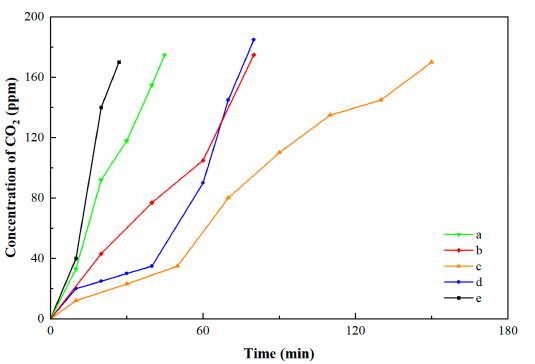
Figure 3. Breakthrough curves of blank carriers were compared at 20 ◦ C: (a) 4A, (b) 5A, (c) 13X, (d) Al 2 O 3 and (e) activated carbon, respectively.